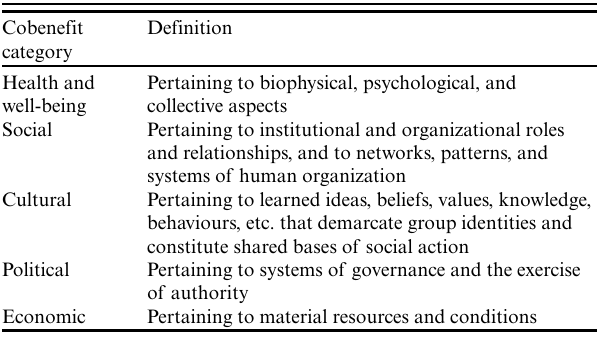
Table 2. Cobenefit category